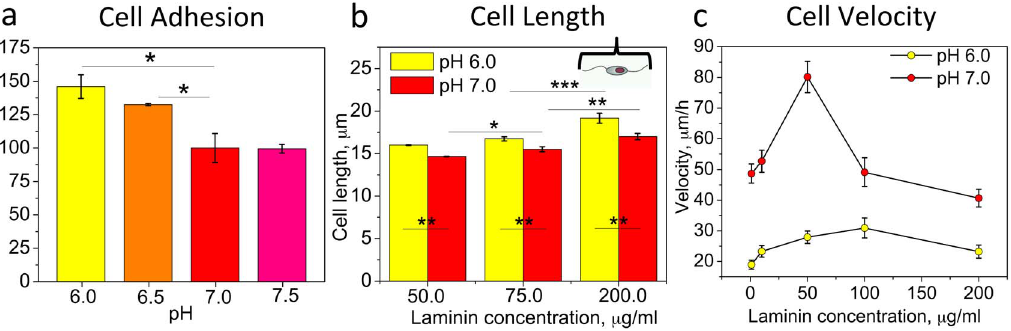
Figure 3. OPC adhesion and length increase at acidic pH. ( a ) Cell adhesion to laminin-coated glass surfaces (10 m g/ml) at different media pH was evaluated as the percentage of cells attached after 1 h incubation in 37 u C on orbital shaker rotating with 1 Hz frequency. Data are mean from three experiments relative to percentage of cells adhered at pH 7.0. ( b ) Dependence of OPC length on extracellular pH (for pH 6.0 and 7.0), for different laminin coating concentrations. Cell length is calculated as a distance between the ends of two longest cell processes (schematically shown in the right top corner). Data are mean from two experiments per condition, N=50 cells per experiment. ( c ) Dependence of OPC migration velocity on laminin coating concentration, for pH 6.0 and 7.0. Data are mean for N=60 cells per point. For each laminin concentration, the difference between cell velocity at pH 6.0 and 7.0 is statistically significant. ( a–c ) Error bars are SEM; * p , 0.05, ** p , 0.01, *** p , 0.001. Colors correspond to cell media